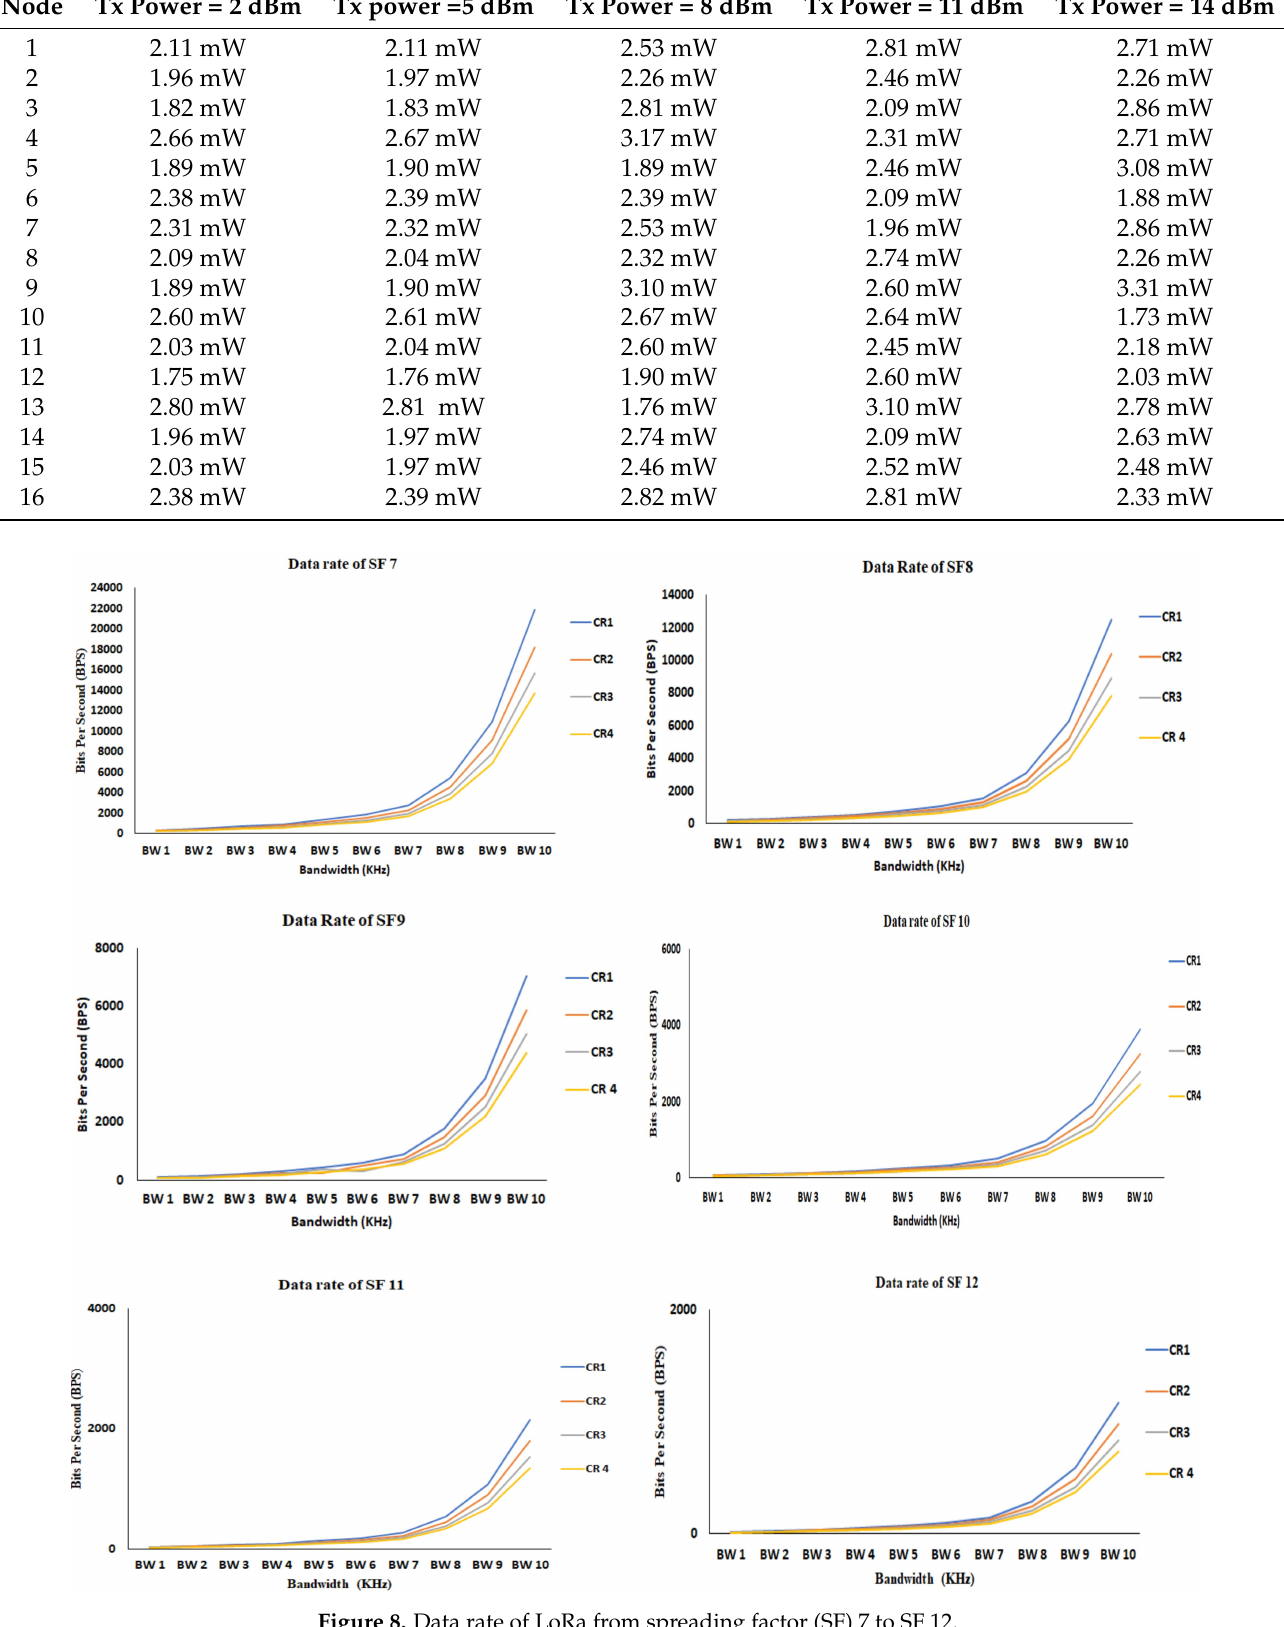
Table 7. Energy consumption of nodes ‘4’.